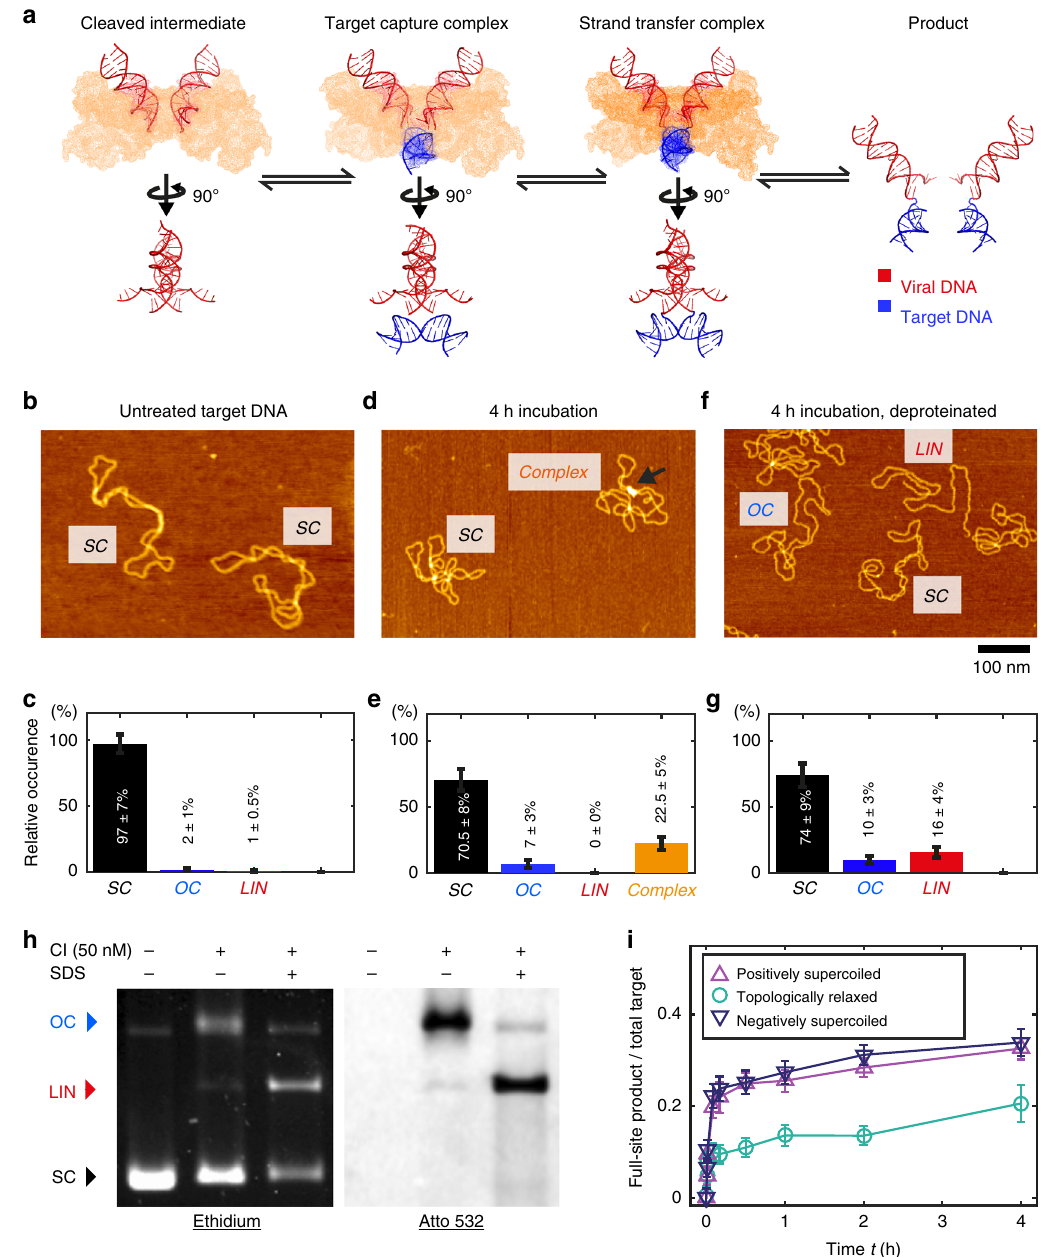
Fig. 1 Topology and yield of strand transfer intermediates. a Reaction schematic of PFV strand transfer with crystal structures of nucleoprotein intermediates (PDB 3l2r, 3os0, 3os1). b AFM image of untreated supercoiled plasmids. c Relative occurrence of supercoiled (SC), open circular (OC), and ffiffiffi p = n linear (LIN) topologies in untreated plasmid samples ( n tot = 214; errors are n ). d AFM image of supercoiled plasmids incubated with CI (10 nM; 4 h, tot 37 °C). e Relative occurrence of different free DNA topologies and nucleoprotein complexes, in samples of supercoiled plasmid incubated with cleaved ffiffiffi p = n intermediate (10 nM; 4 h, 37 °C) ( n tot = 518; errors are n ). f AFM image of sample after incubation with CI and subsequent deproteination. g Relative ffiffiffi p tot = n occurrence of DNA topological forms in deproteinated samples of supercoiled plasmid incubated with CI ( n tot = 100; errors are n tot ). The linearized fraction increases signi fi cantly after deproteination compared with the other two conditions ( p < 0.0001 in both cases). h Gel electrophoresis of untreated plasmids ( fi rst lane), and native (secondlane) and deproteinated (third lane) reaction products of supercoiled pBR322 and intasomes assembled on Atto532-labeled viral DNA mimetics (left: ethidium bromide stain; right: Atto532 dye). i Ratio of full-site product to total DNA as a function of incubation time, deduced from electrophoretic separation of reaction mixtures of plasmids with different supercoiling density and CI intasome (25 nM), followed by Sybr Gold staining. Error bars are SD from two independent repeats. Source data are provided as a Source Data fi intasomes under non-reactive conditions and ensemble kinetic sites remain engaged in the STC (Fig. 2g and Supplementary analysis suggest that branched complexes, stabilized by auxiliary Fig. 2). DNA-binding interfaces, constitute on-pathway intermediates The exit-angle distributions of DNA in branched and bridging during target capture (Supplementary Figs. 3 and 4). Further, complexes are well-de fi ned, suggesting conserved folding (Fig. 2h, i). AFM imaging of gel-puri fi ed STCs demonstrate that auxiliary Based on high-resolution structural information 14,22 and our